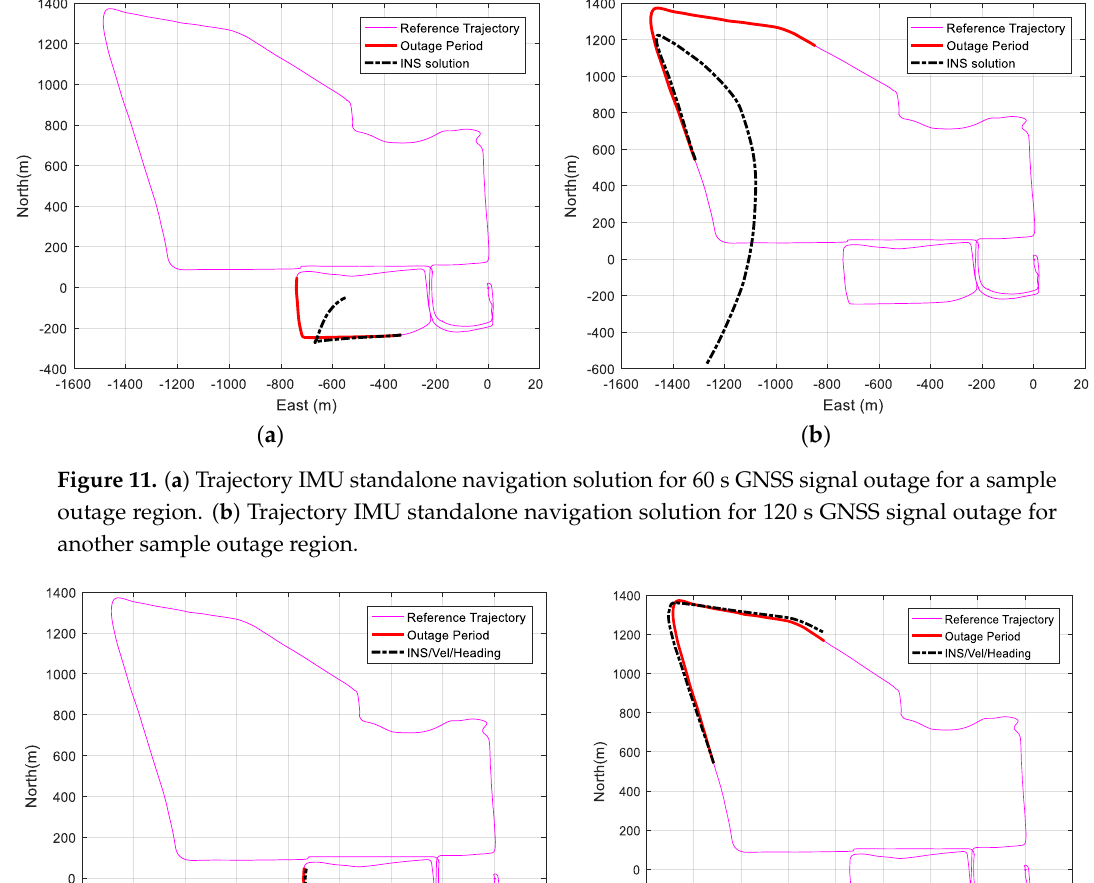
Table 3. Average RMSE of the integrated 2D position states for heading change and velocity updates for different GNSS signal outage periods.